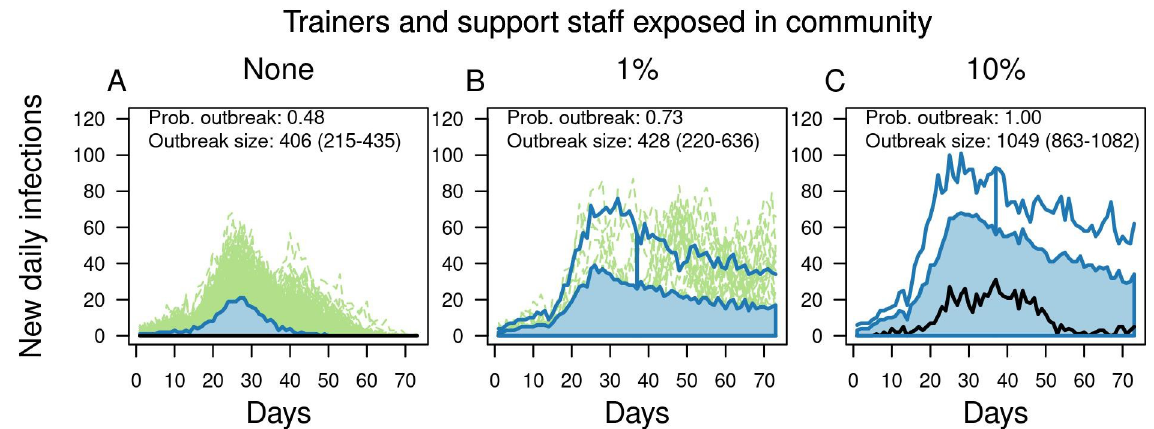
Fig 4. Outbreaks in basic training as a function of community exposure of trainers and support staff. From left to right, columns show increases from 0 to 0.01 to 0.10 of the probability that trainers and support staff were exposed to the virus in the community over the course of the 70-day training period. Each panel contains a functional boxplot of the daily incidence of new infections across 1,000 replicate simulations showing the median estimate (black line), 50% central region (25–75%) (blue band), 1.5 times the 50% central region (blue lines), and outliers defined as curves outside of the 1.5 times the central region (dashed green lines). The probability of an outbreak and the median and 25–75% interval of outbreak sizes are printed in each panel.